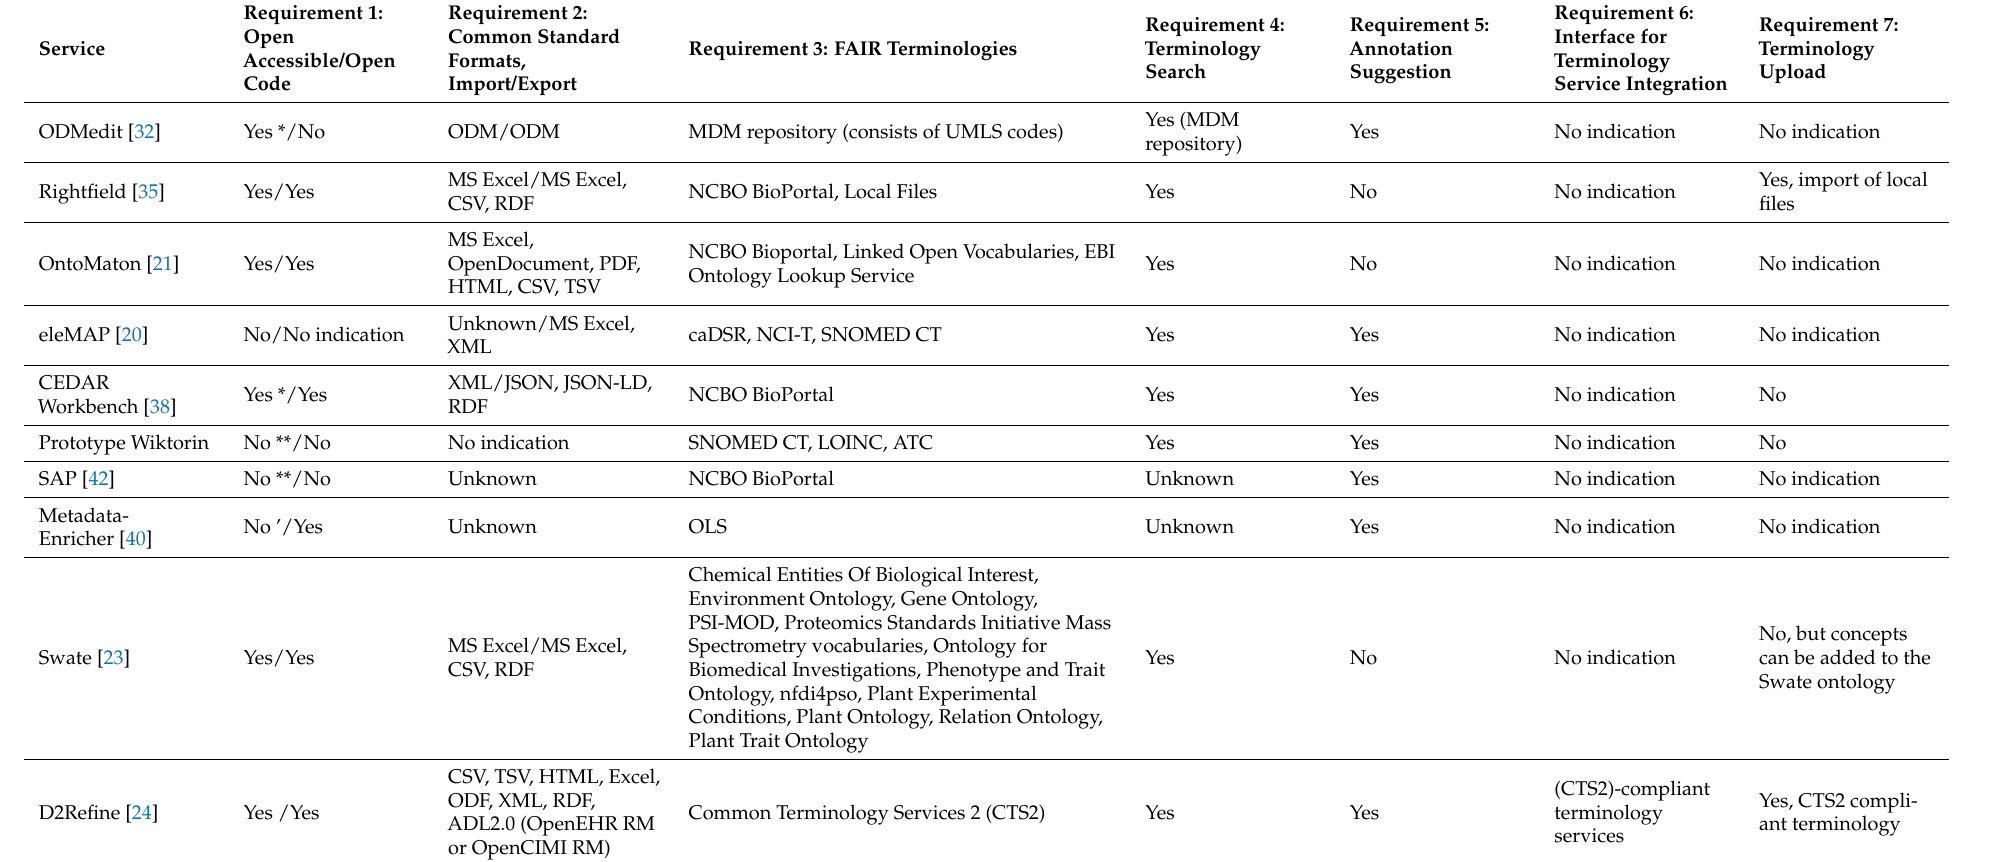
Table 2. Comparison of semantic annotation services for requirements